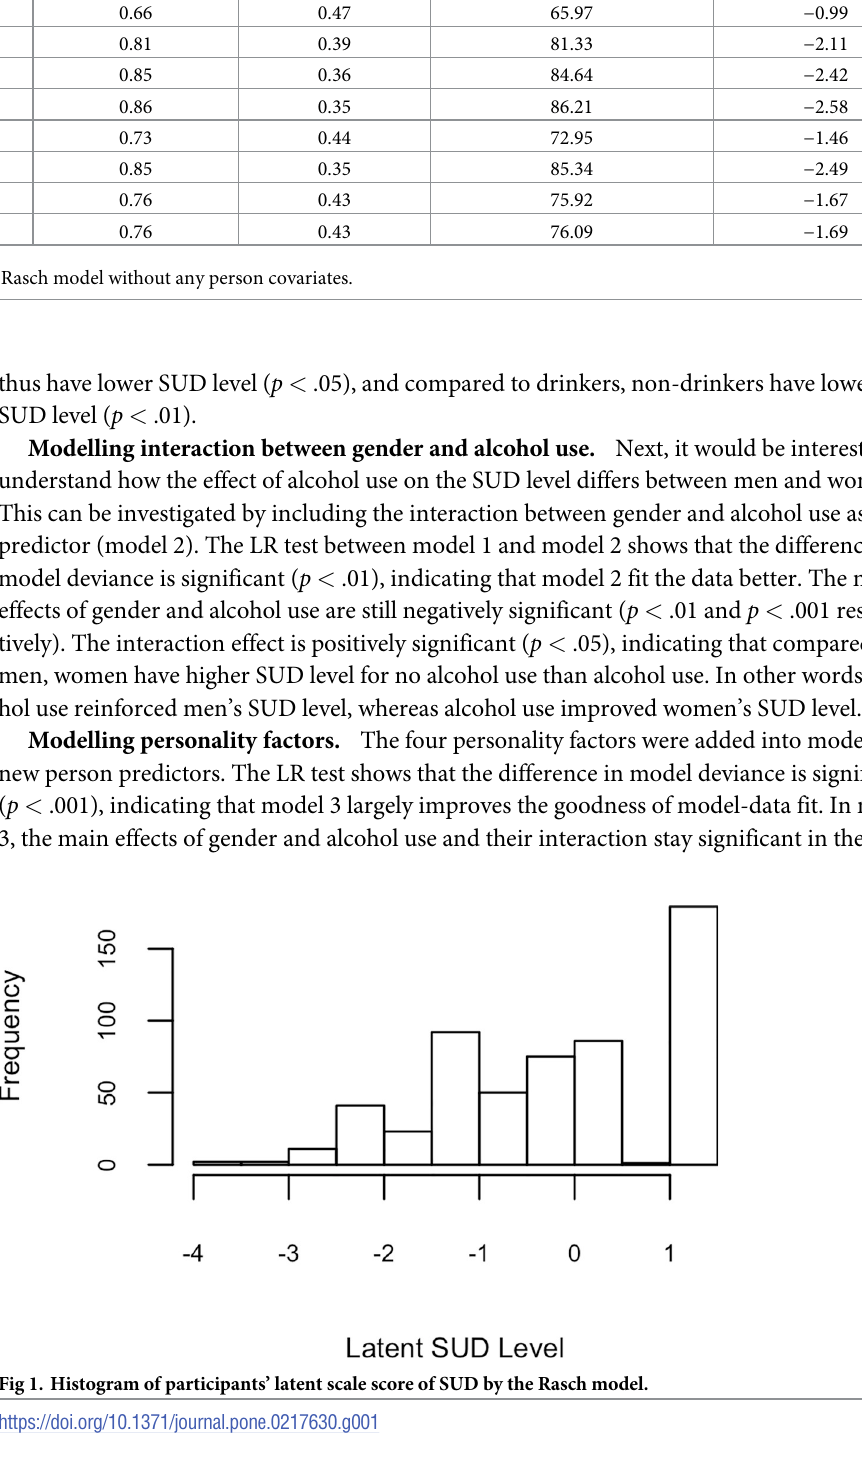
Table 3. Descriptive summary of the DSM-5 SUD criteria.